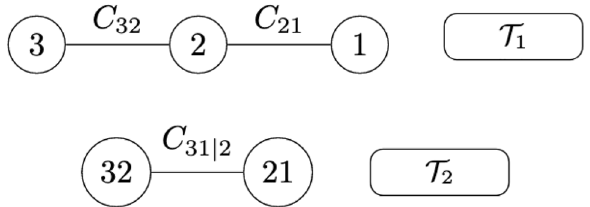
Figure 3. 3-dimensional C-vine